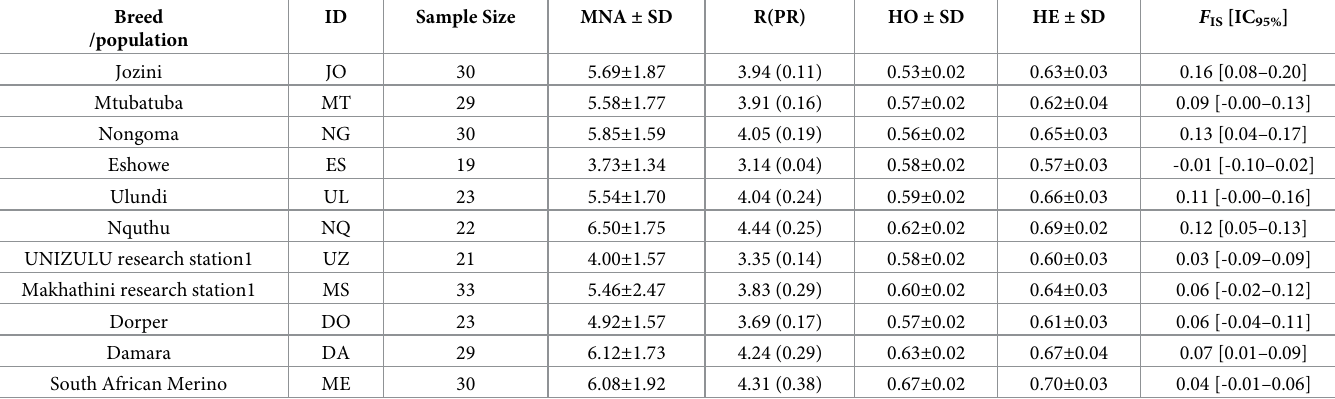
Table 1. Genetic diversity of the studied sheep breeds obtained from the analysis of 26 microsatellite loci. Breed ID Sample /population